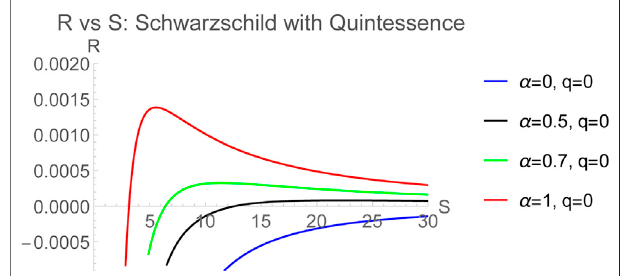
FIGURE 5 | Ruppeiner curvature for Schwarzschild-AdS black hole surrounded by quintessence on the ( S , P ) -plane as a function of S for fi xed P .